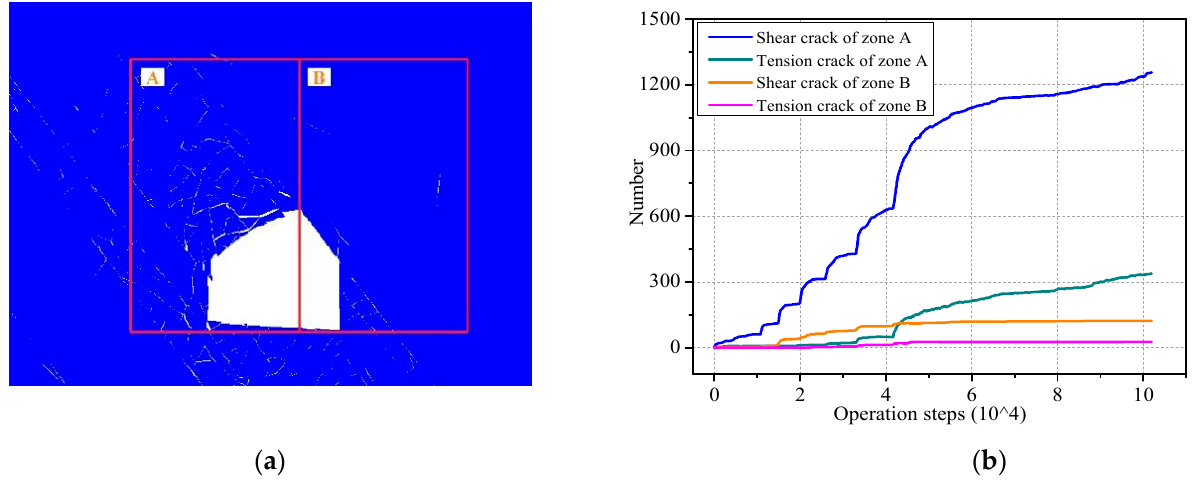
Figure 10. Differential evolution laws of cracks in surrounding rocks. ( a ) Zonal distribution charac- teristics of cracks; ( b ) time-dependent evolution curves of cracks.